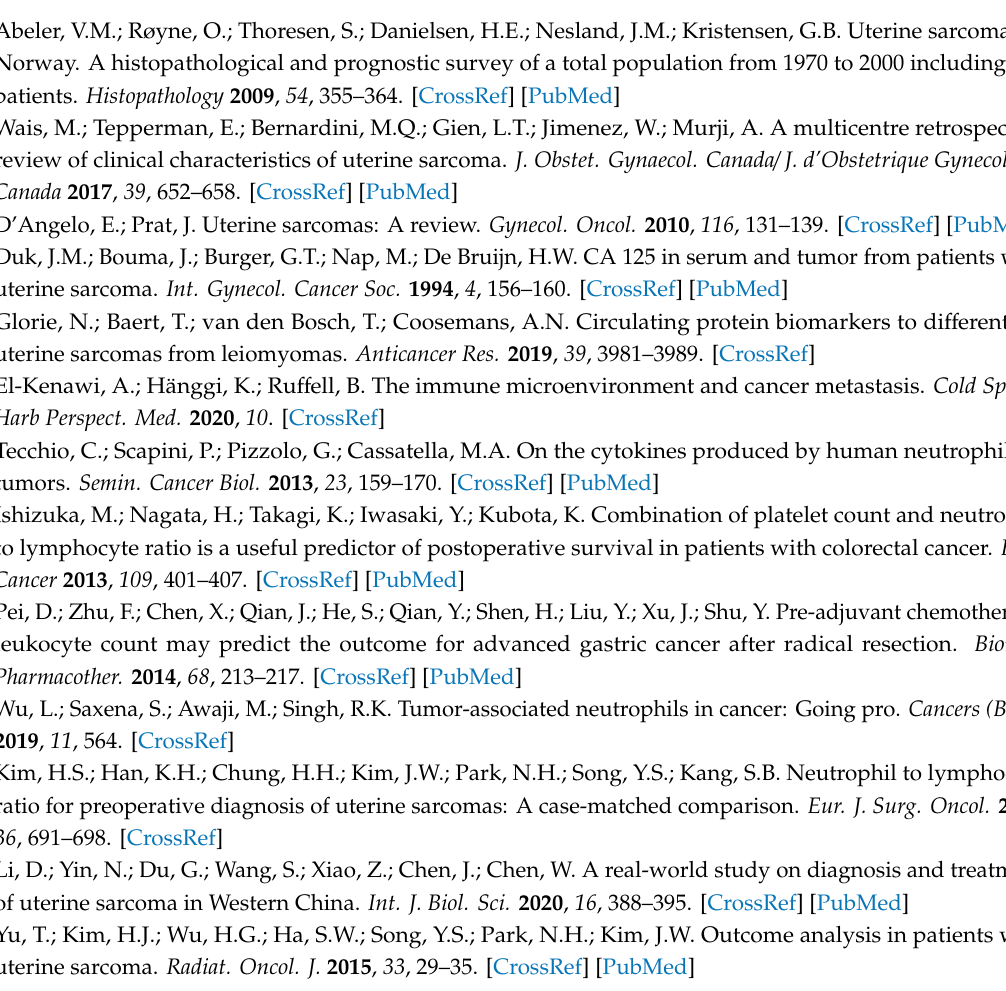
Table S1: The relationship between NLR, PLR level and survival / recurrence rate in stage I uterine sarcoma, Table S2: Baseline characteristics according to Combined NLR and PLR (CNP score), Table S3: Univariate and multivariate analysis of prognostic factors for the Disease-Free